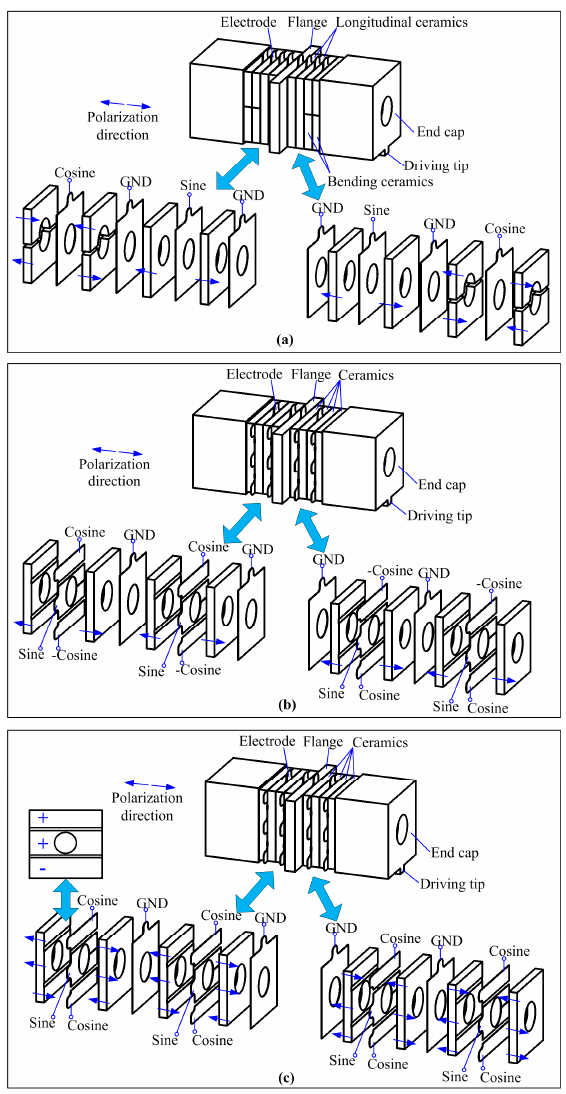
Figure 2. The arrangements of the piezoelectric ceramic plates and the applied exciting signals under different exciting methods: ( a ) the traditional exciting method for longitudinal-bending hybrid vibrations using separated longitudinal and bending ceramics; ( b ) the new exciting method for longitudinal-bending hybrid vibrations using whole-piece type ceramic plates with three uniform polarized partitions; ( c ) the new exciting method for longitudinal-bending hybrid vibrations using whole-piece type ceramic plates with three converse polarized partitions.